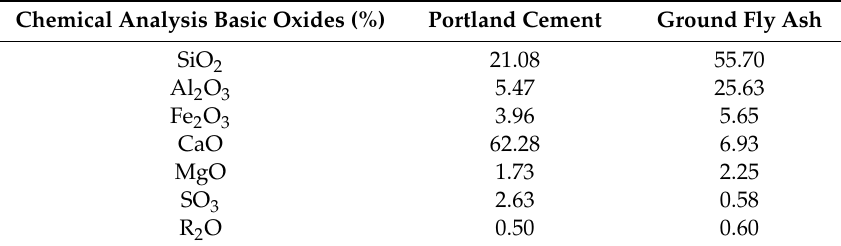
Table 1. The chemical compositions of binders.